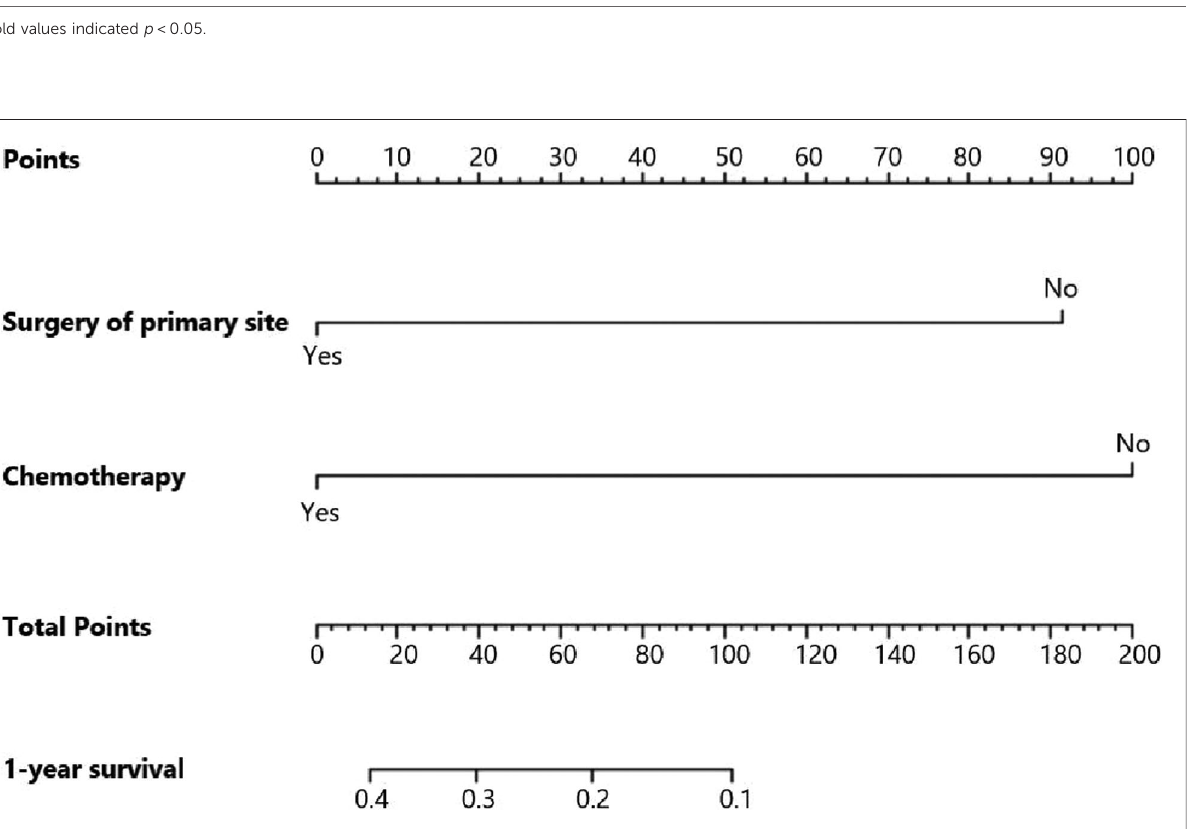
FIGURE 6 Nomogram for predicting 1-year survival of gallbladder cancer patients with liver